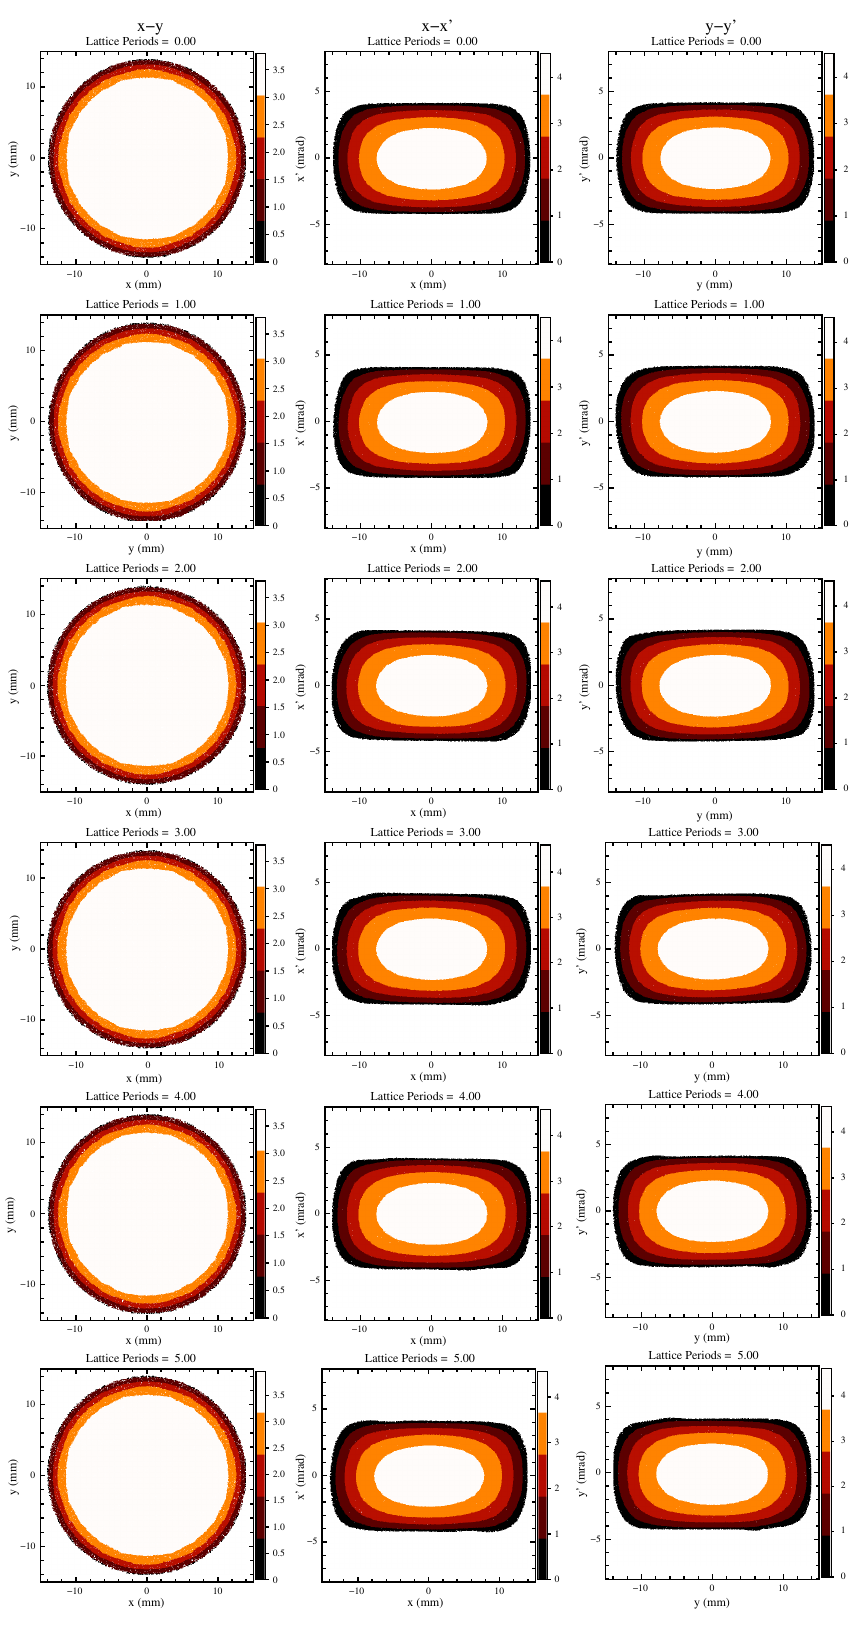
FIG. 8. (Color) Evolution of phase-space projections in x - y , x - x 0 , and y - y 0 for the initial pseudoequilibrium waterbag distribution ¼ 45 (cid:5) and (cid:3)=(cid:3) ¼ 0 : 2 . Projections (columns) are shown at lattice period intervals simulation shown in Figs. 6 and 7 with (cid:3) 0 0